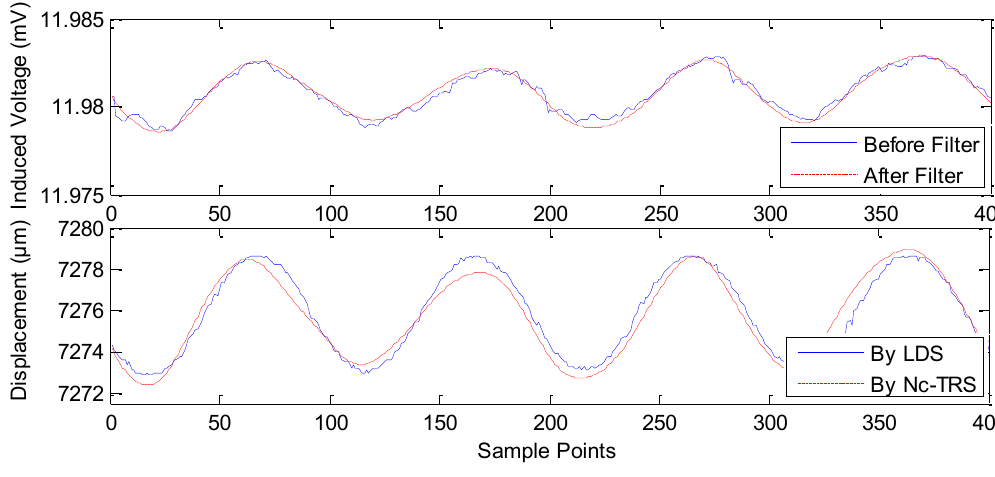
Figure 9. The sensing effect under applied current I ( t ) = 0.5sin(2  ft ) A ( f = 10 Hz).